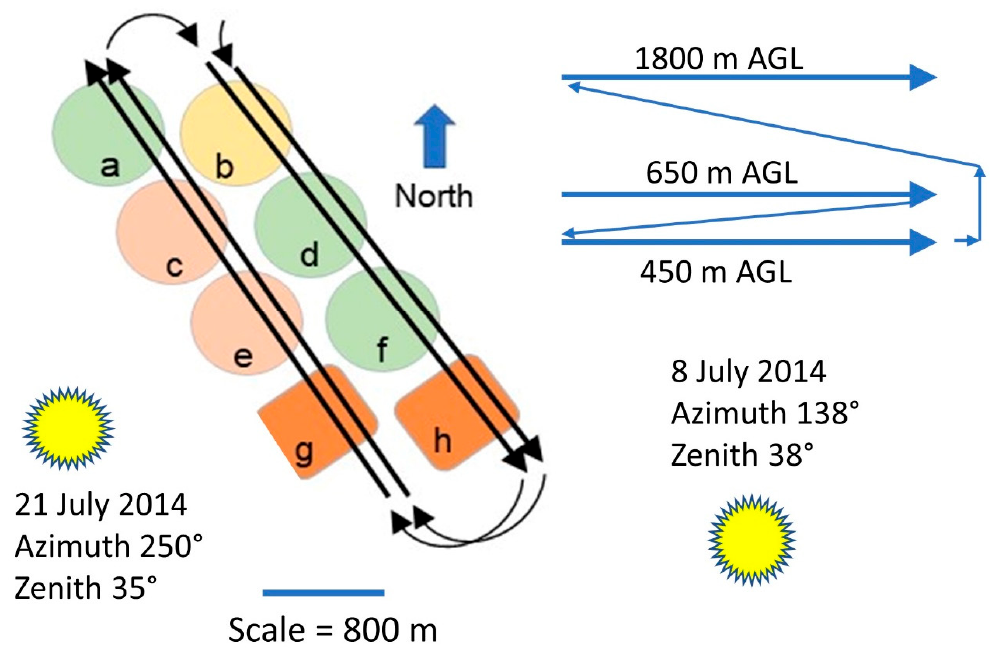
Figure 1. Experimental layout for Unmanned Aircraft Systems (UAS) flights on two dates over six Figure 1. agricultural fields with center-pivot irrigation and two fields of sagebrush steppe. Fields (a), (c), (e), and (g) were always flown with a northwest bearing, whereas fields (b), (d), (f), and (h) were always flown with a southeast bearing. Flight lines were 29 ◦ from alignment with the solar azimuth on 8 July 2014, whereas the flight lines were 6 ◦ from being perpendicular to the solar azimuth on 21 July 2014. Each flight consisted of three altitudes: 650, 450, and 1800 m above ground level (AGL). Colors represent potato (light green; fields a, d, and f), spring wheat (tan; fields c and e), maize (yellow; field b), and sagebrush steppe (brown; fields g and